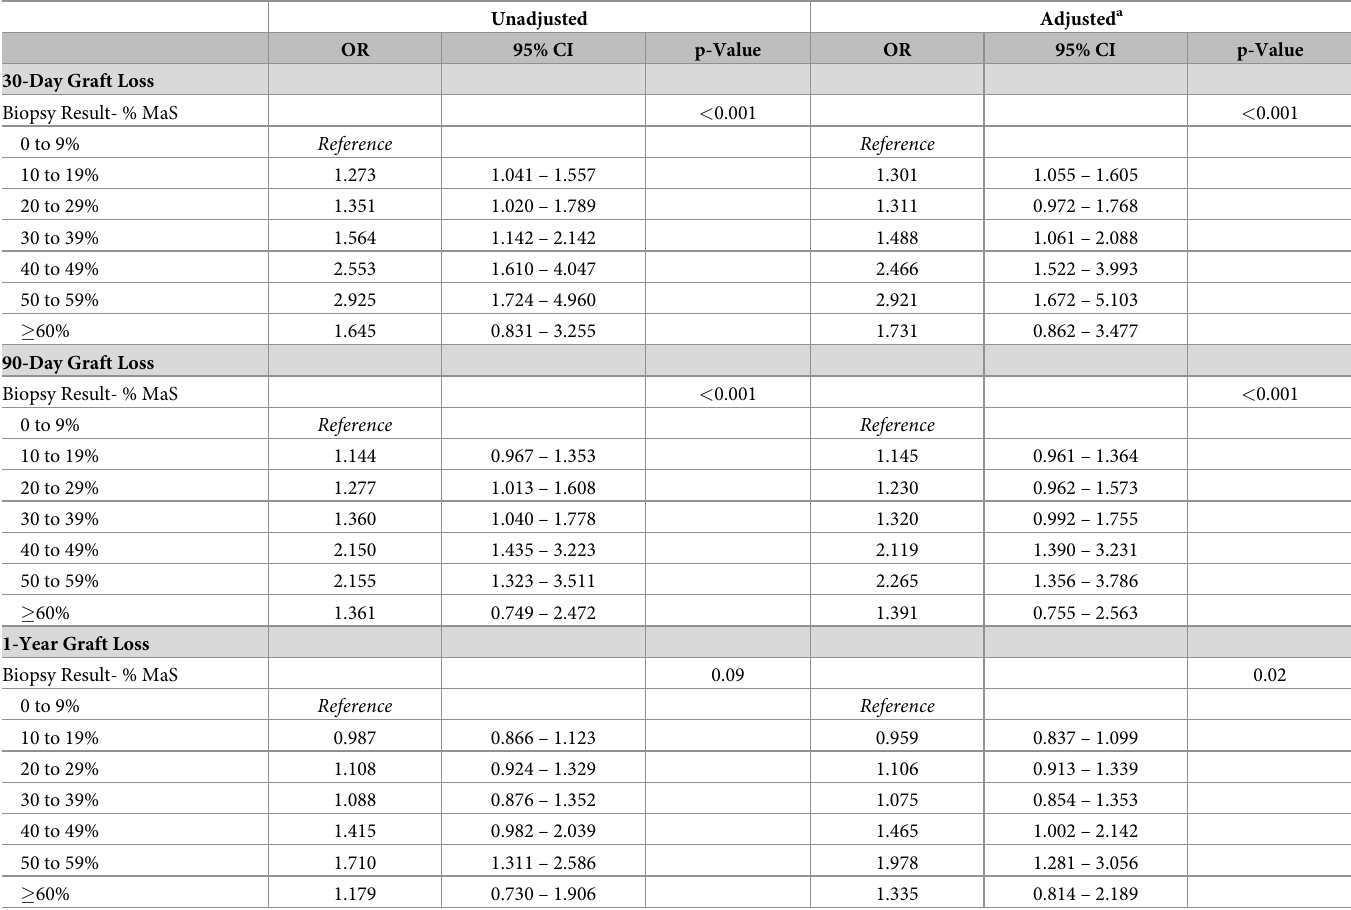
Table 3. Likelihood of graft loss with donor liver macrosteatosis after